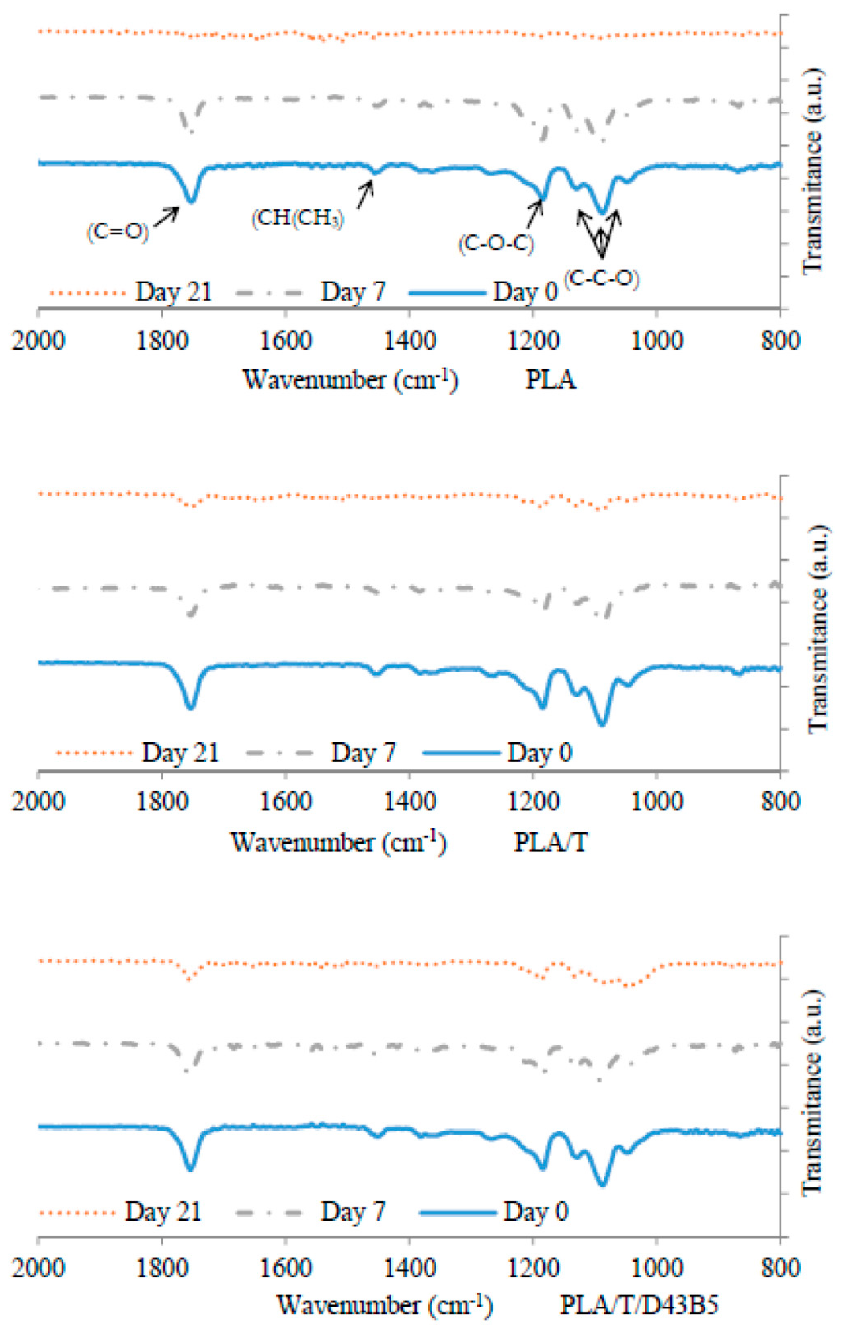
Figure 2. FTIR spectra of PLA, PLA/T, and PLA/T/D43B5 before (0 days) and after different incubation times (7 and 21 days) under composting conditions.